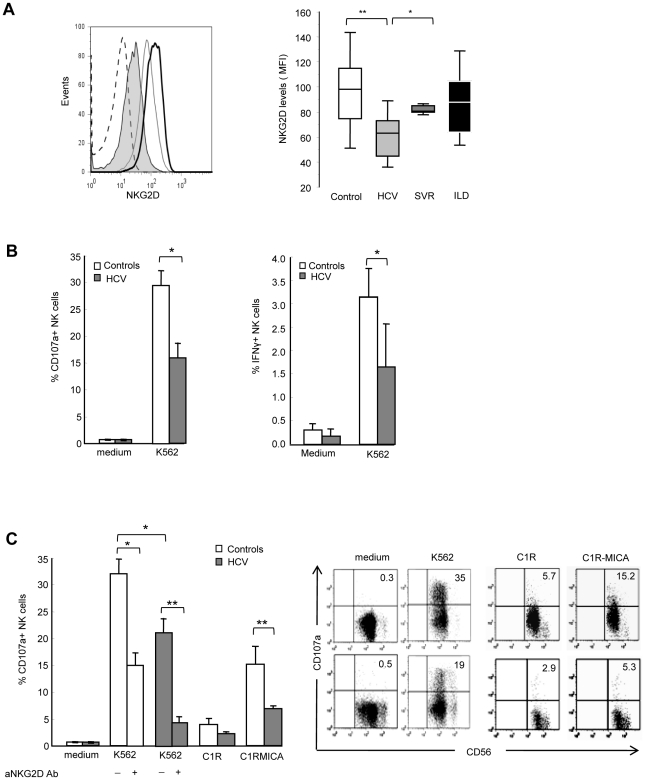
NKG2D levels and NK cell functions are altered in HCV-infected patients.A) Freshly isolated PBMCs were stained with CD56, CD3 and NKG2D mAbs, and analyzed by FACS. Gating on CD3-CD56+ cells identified NK cells. Left panel: Representative NKG2D staining in one healthy control (dark line), one chronically-infected HCV patient (plain gray) and one HCV patient with sustained viral response (SVR, empty gray). Isotype control is shown in dotted line. Right panel: Combined data showing the mean NKG2D levels on NK cells from 23 controls, 41 HCV patients, 9 patients with SVR, and 9 patients with non-infectious inflammatory liver disease (ILD). Data are expressed as box plots, in which the horizontal lines illustrate the 25th, 50th, and 75th percentiles of the MFI of NKG2D. The vertical lines represent the 10th and 90th percentiles. * P<10−4, ** P<10−3. B) Frequency of CD107a+ degranulating (left panel) or IFNγ-producing (right panel) NK cells incubated for 6 hr in medium alone, or in the presence of MHC class I-negative K562 cells (E∶T ratio 1∶1). Results show the mean ± SEM values in 11 HCV patients and 15 healthy controls. * P = 0.003. C) Frequency of CD107a+ NK cells incubated for 6 hr with K562 cells (alone or in the presence of 20 µg/ml of NKG2D blocking mAb or control IgG), C1R cells or C1R-MICA transfectants. E∶T ratio 1∶1. Left panel: Combined data in 6 HCV patients (grey bars) and 6 healthy controls (white bars). * P = 0.003, ** P = 0.0001. Right panel: Dot plots show a representative experiment in one control (upper line) and one HCV patient (lower line). Numbers in the quadrant indicate the percentage of CD107a+ NK cells.